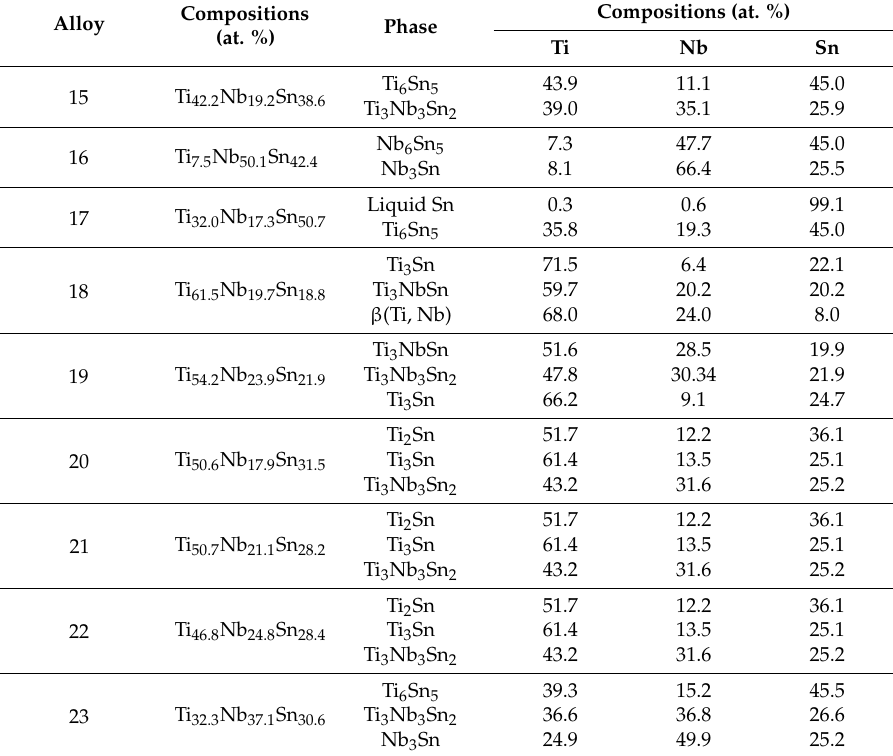
Following similar analytical procedures, two phases coexisted: a gray solidification phase Nb 3 Sn and gray matrix phase Nb 6 Sn 5 . The results agree with the XRD diffractogram of alloy 16 in Figure 3b. Figure 2c is the microstructure of Alloy 17 (Ti 32.0 Nb 17.3 Sn 50.7 ). It displays a bright gray phase liquid Sn with some holes and the gray matrix phase Ti 6 Sn 5 coexisted. It agrees with the XRD patterns of alloy 17 in Figure 3c. Figure 2d–g features the microstructure of three phase region alloys. Figure 2d is the microstructure of Alloy 18 (Ti 61.5 Nb 19.7 Sn 18.8 ). Two precipitates dark gray phase Ti 3 Sn and gray stripy phase β (Ti, Nb), as well as a bright gray matrix phase Ti 3 NbSn were observed. Figure 2e shows the microstructure of Alloy 19 (Ti 50.7 Nb 21.1 Sn 28.2 ). There are two solidification phases, gray reticular phase Ti 3 NbSn and black gray stripy phase, as well as bright gray matrix phase Ti 3 Nb 3 Sn 2 coexisted in the alloy.